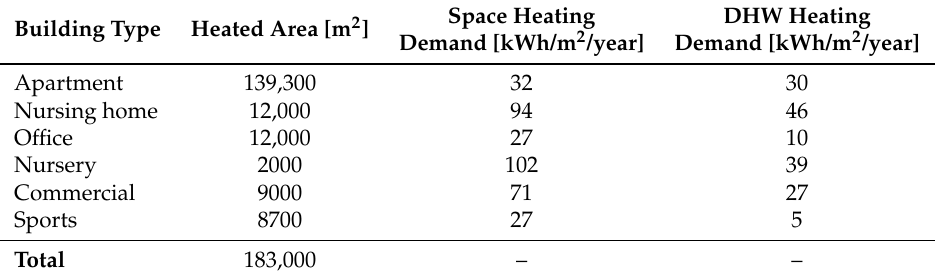
Figure 1. Architectural illustration of the planned building area at Leangen (scale 1:1000, obtained with permission from [19]), together with a sketch of the planned local heating network. Table 1. The building mass to be built at Leangen, together with the calculated annual specific space and domestic hot water (DHW) heating